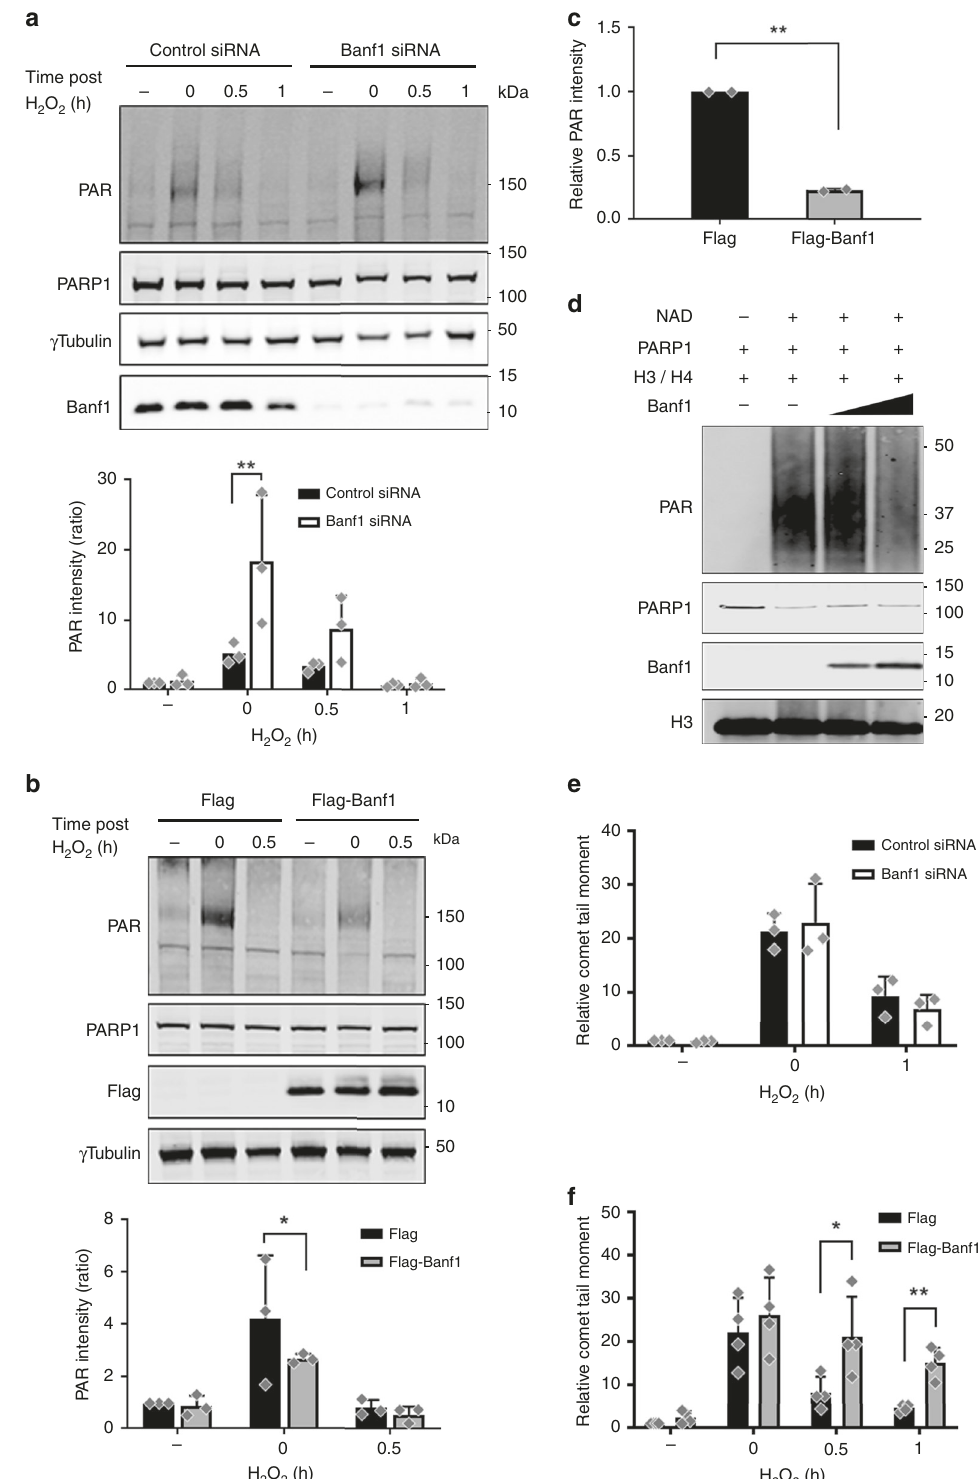
and Supplementary Fig. 6c, d) and P32 labelled NAD + to PARP1 (Supplementary Fig. 6e), supporting the prediction that Banf1: PARP1 binding inhibits NAD + binding. In support of this